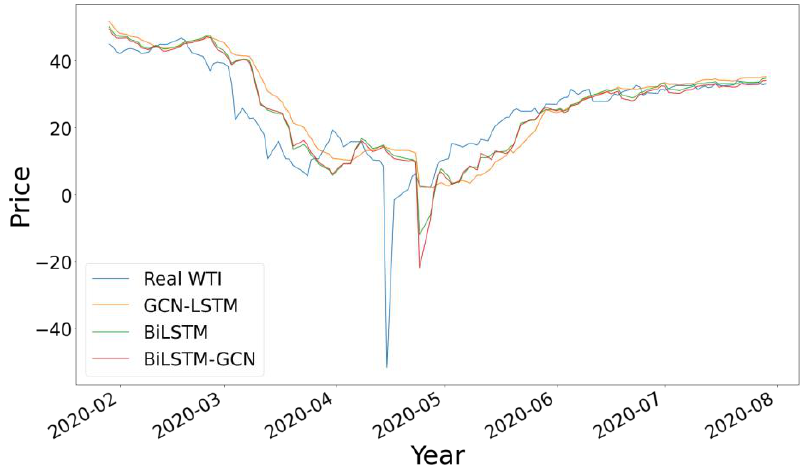
Figure 9. Comparison among the three DNN model-based approaches.